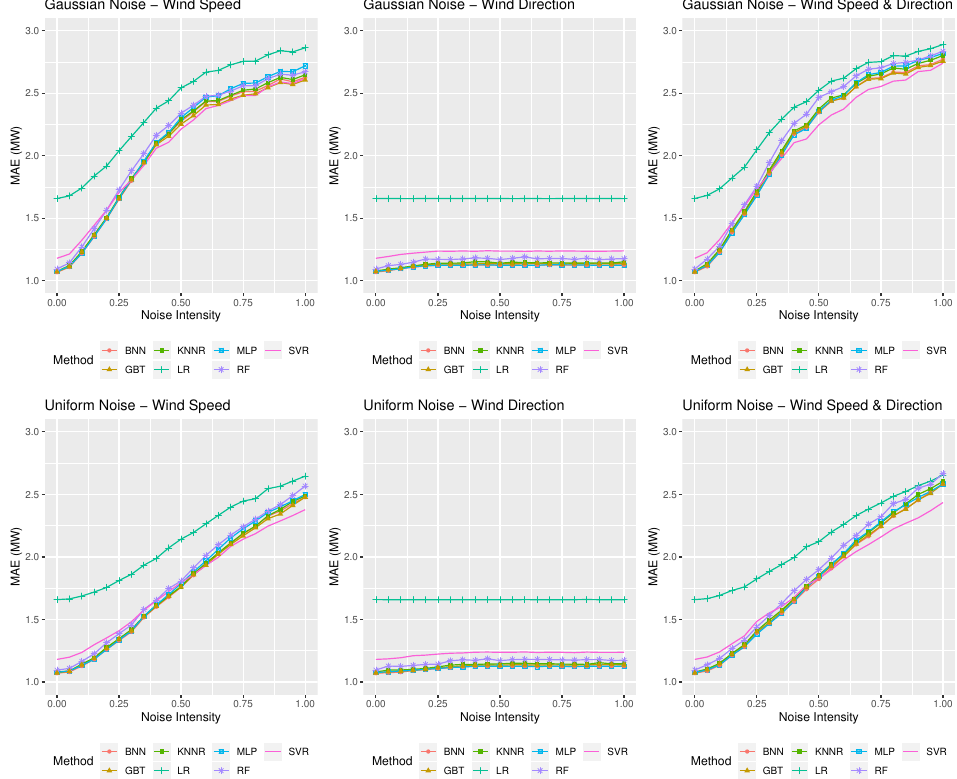
Figure 5. Forecasting performance in terms of wind power point forecasts (mean absolute error (MAE), measured in MW) of the statistical and machine learning (ML) methods considered in this study for the Aeolos wind farm when different types of noise and noise intensities are considered. The three panels on the top display the accuracy of the methods for the case of the Gaussian noise of various intensities, σ , applied to wind speed forecasts, wind direction forecast, and both, respectively. The three panels at the bottom display the same results for the case of the uniform noise of various intensities s